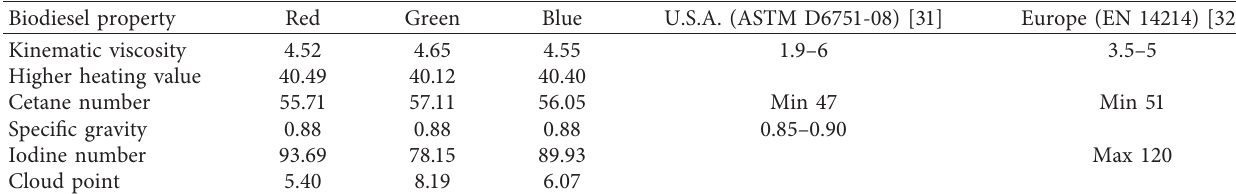
Table 1: Biodiesel properties of Golenkinia SDEC-16 cultured under the red, green, and blue lights. Biodiesel property Red Kinematic